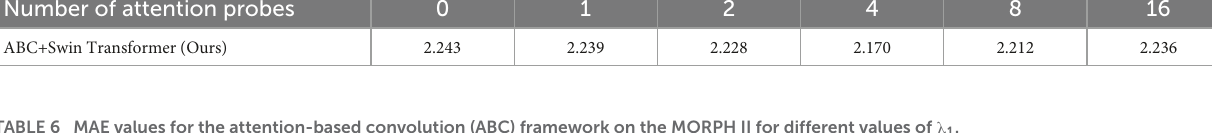
TABLE 6 MAE values for the attention-based convolution (ABC) framework on the MORPH II for different values of λ 1 . Value of λ